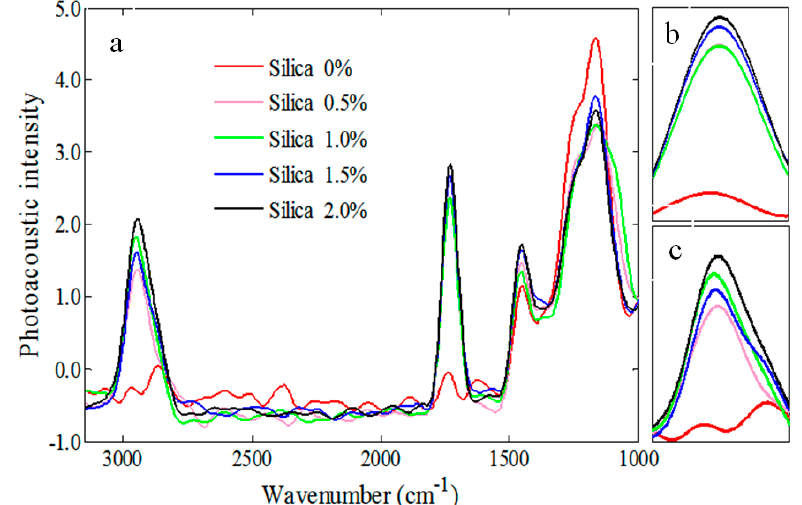
Figure 2. FTIR spectra ( a ) of the pure polyacrylate film (silica 0 wt.%) and hybrid films with 0.5 wt.%, 1.0 wt.%, 1.5 wt.%, and 2.0 wt.% silica. The subintervals of the spectra 1650–1800 cm − 1 ( b ) and 2800–